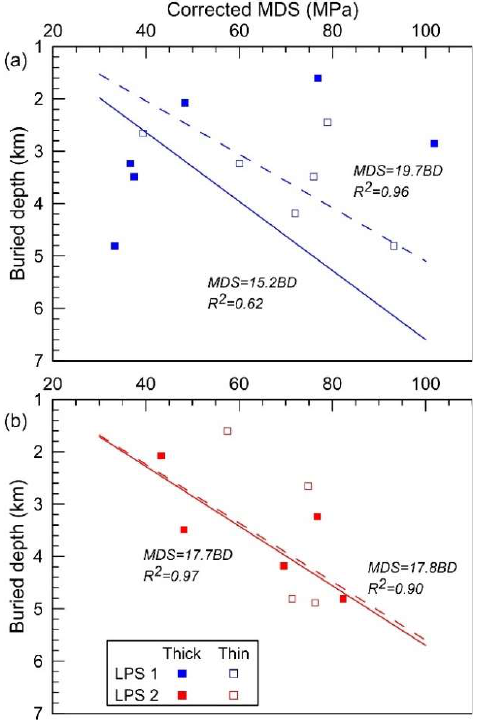
Figure 12. Buried depths vs. the corrected MDSs for (a) the LPS1 subset and (b) the LPS2 subset.